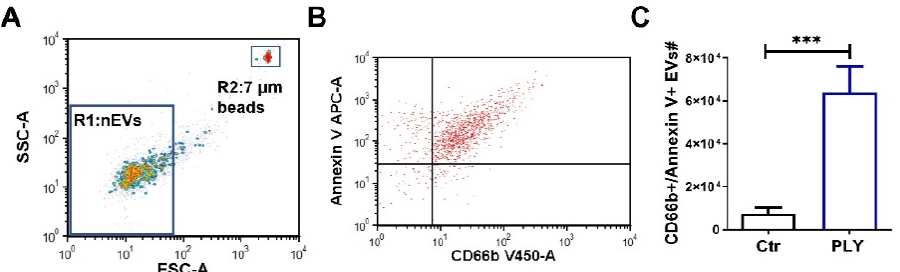
Figure 3. Pneumolysin induces extracellular vesicle release from human neutrophils. Human neutrophils were treated with PLY (100 ng/mL, 1h) or vehicle (Ctr). Neutrophil-EVs (nEVs) were isolated from the cell culture supernatant and analyzed by flow cytometry. ( A ) Representative dot plot of isolated human nEVs. Gate 1 (R1) includes events less than 1 µ m; 7 µ m counting beads were included in each sample for nEV quantification (gate 2; R2). ( B ) Representative dot plot showing nEVs after staining with annexin V and CD66b (double-positive events are within the upper right quadrant), and ( C ) Quantification of nEVs released from Ctr and PLY-treated neutrophils. n = 9. *** p < 0.001, paired t -test.